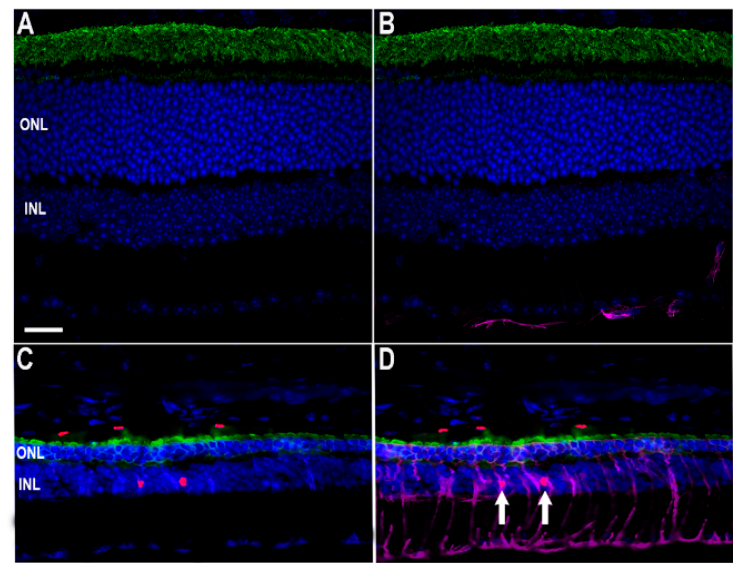
Figure 5. Identification of Müller cell nuclei as INL centers for STAT3 activation. To assess which retinal cells exhibited STAT3 phosphorylation, labeling was performed on +/+ ( A , B ) and Ter349Glu/Ter349Glu ( C , D ) animals for glial fibrillary acidic protein (purple), a marker of astrocytes and gliotic Müller cells, rhodopsin (green), and pSTAT3 (red). Nuclei were labeled with DAPI (blue). Arrows show red nuclei surrounded by purple. Scale bar = 20 μ m. Cells 2020 , 9 , x